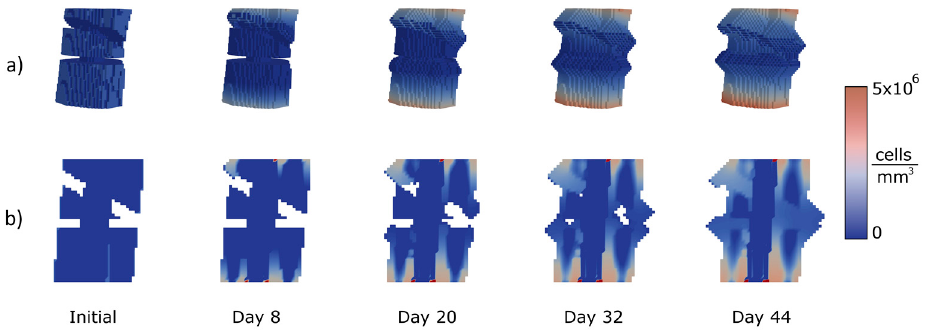
Figure 9. Calculation of concentrations (MSCs) and growth for a comminuted fracture with a com- bination of a 30° slope and a transverse shape with 3 mm gap: ( a ) 3D view of the callus growth process; ( b ) Sagittal section along femoral axis.